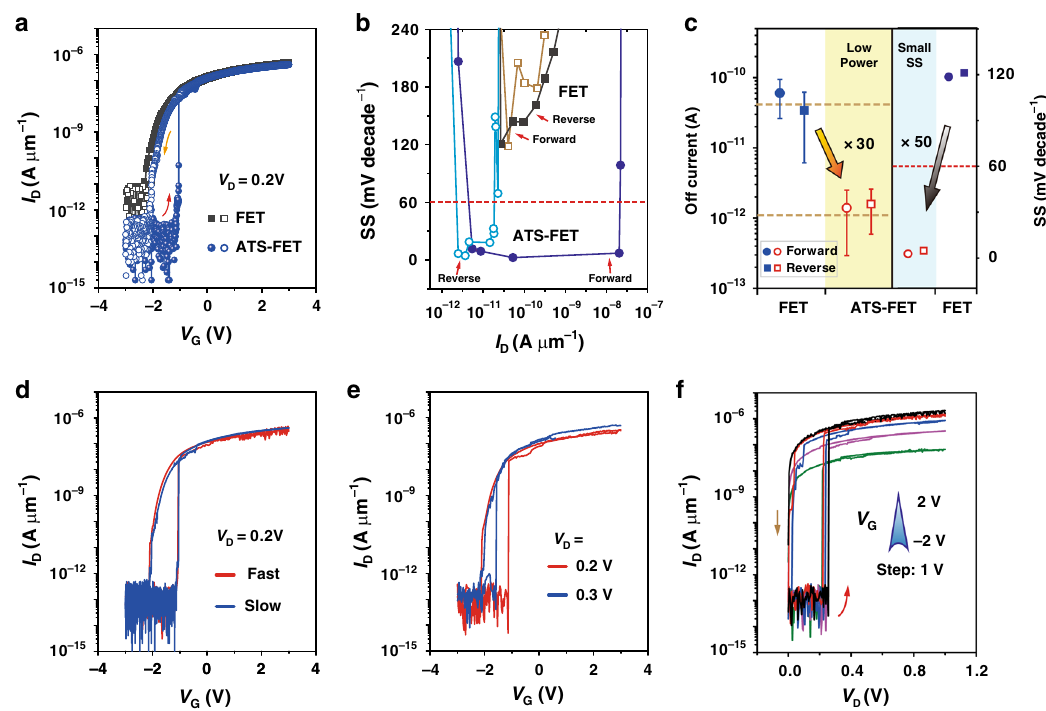
Fig. 2 Device performances of the ATS-FET. a Transfer curves from the ATS-FET and FET with the same 2D MoS 2 channel (channel width: 10 μ m; channel length: 2 μ m). Solid symbols indicate the forward sweep, while open symbols indicate the reverse sweep. b SS from the ATS-FET and FET both in forward and reverse sweeps. The FET operates well above the fundamental thermionic limitation, while the ATS-FET has a large range of the drain current where the minimal SS is 2.5 mV decade − 1 . c The off-state leakage current and SS can be simultaneously reduced in the ATS-FET, indicating the ultralow-power steep-slope phenomenon in the ATS-FET. d I D – V G characteristics measured at room temperature and at V D = 0.2 V at slow/fast gate voltage sweep speeds. The V G steps were set to 3 and 30 mV, respectively. e Transfer characteristics ( I D – V G ) measured at room temperature and at V D = 0.2 and 0.3